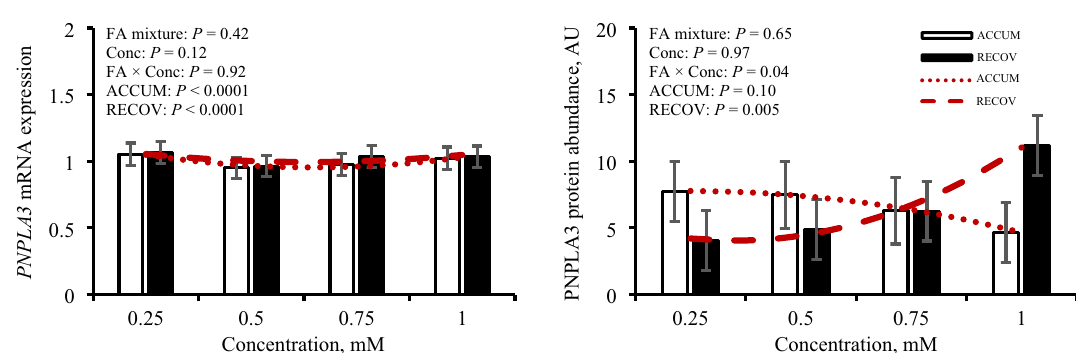
Figure 2. Gene expression and protein abundance of patatin-like phospholipase domain-containing protein 3 (PNPLA3) in response to fatty acid (FA) mixture representing liver lipid accumulation (ACCUM; open bars and dotted line) and fatty acid mixture representing liver lipid clearing (RECOV; closed bars and dashed line) at different concentrations in primary bovine hepatocytes. Data is presented as least squares mean ± standard error of the means. Quadratic relationships are displayed if P ≤ 0.15 for a main